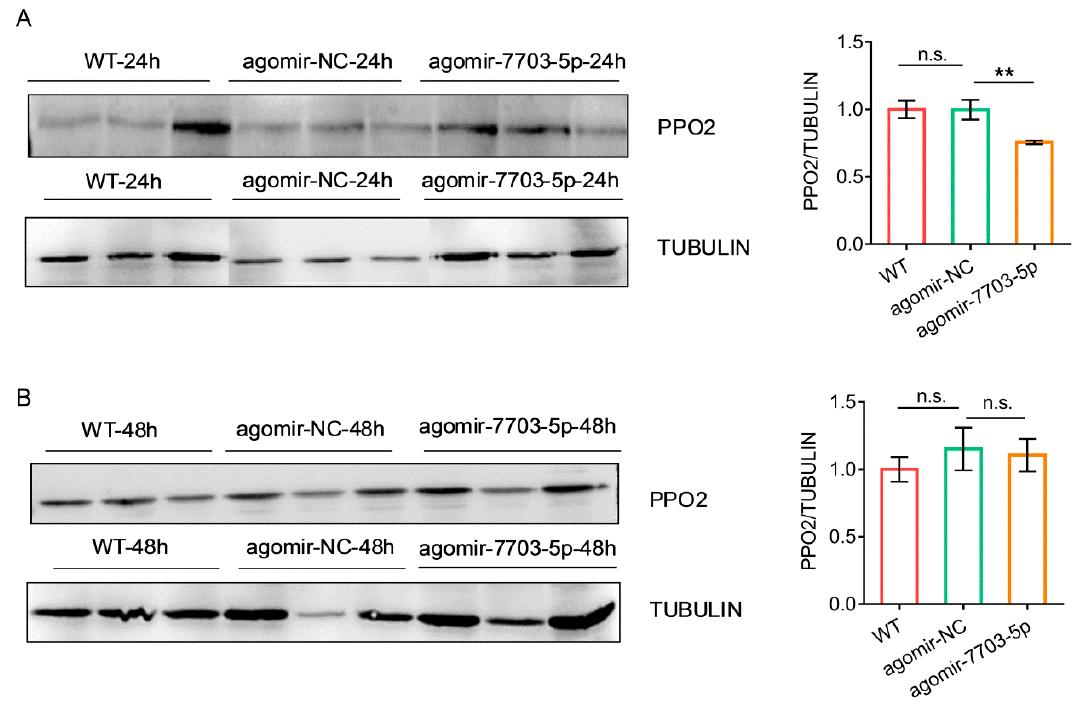
Figure 3. Changes of the protein level of PPO2 in response to the agomir-7703-5p treatment. ( A ) and ( B ). Western blots against PPO2 (left) and normalized PPO2 expression levels (right) at 24 h ( A ) and 48 h ( B ) post-injection of agomir-7703-5p. Tubulin was used as a loading control. WT: Untreated larvae; agomir-NC: Larvae treated with control miRNA; agomir-7703-5p: Larvae treated with agomir-7703-5p. Integrated densities of protein bands were calculated using ImageJ and PPO2 levels were normalized against tubulin levels. Data were presented as mean ± SD (Student’s t test, n.s. indicated non-significant, ** p < 0.01).